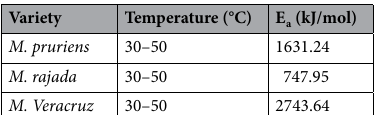
Table 3. Activation energy of hydration of each variety of Mucuna beans.